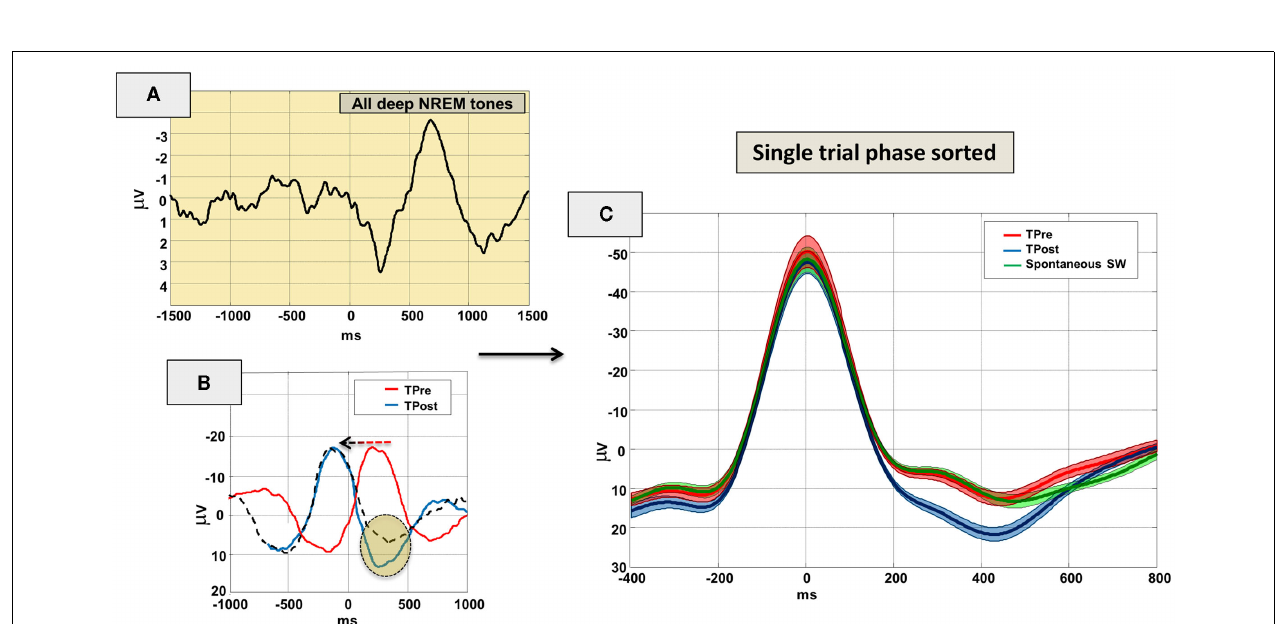
FIGURE 4 | Grand-averaged EEG brain activity in response to sounds during (A) waking and NREM sleep as well as (B) in response to the occurrence of sleep spindle events. Note the decreasing signal complexity from waking (black line), to light (red) to deep (blue) NREM sleep (left panel) in response to tones. On the right, EEG responses to